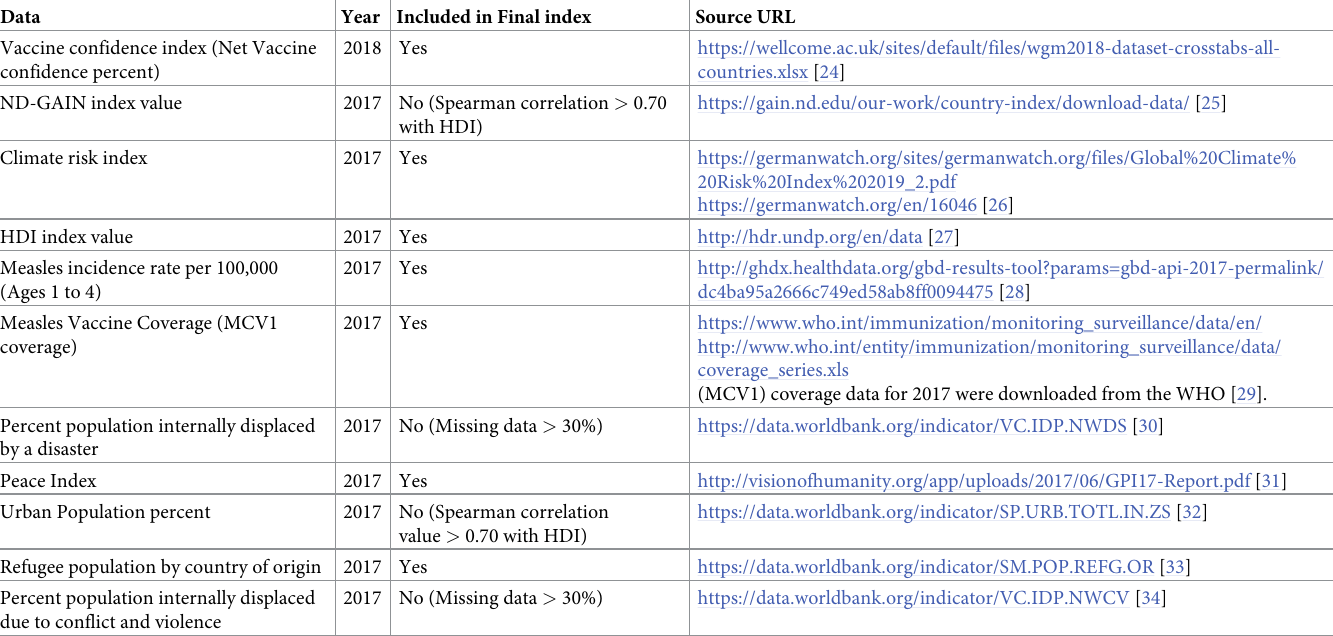
Table 1. Sources for the variables and parameters considered in assessing a Vaccine Risk